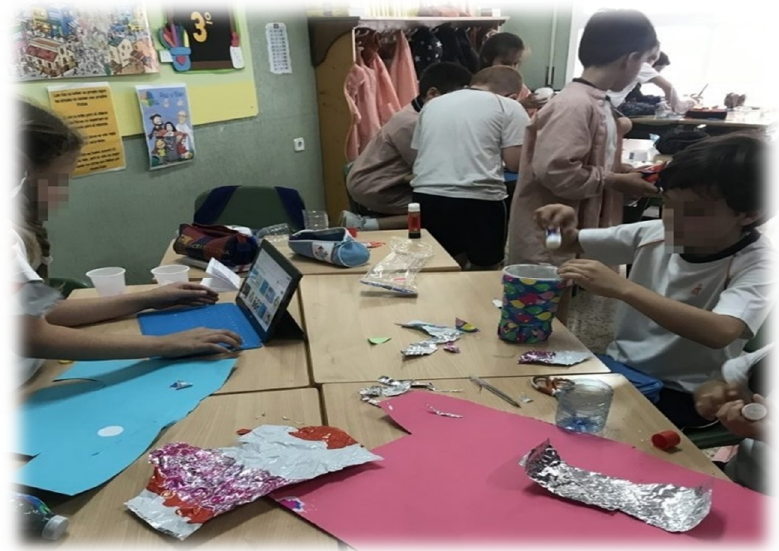
Figure 5. Students working in a group with a range of materials.